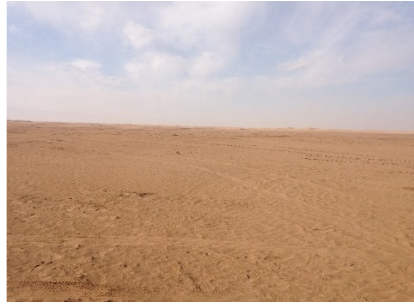
Figure 1. Desert target used for field calibration at the Baotou site in this study.